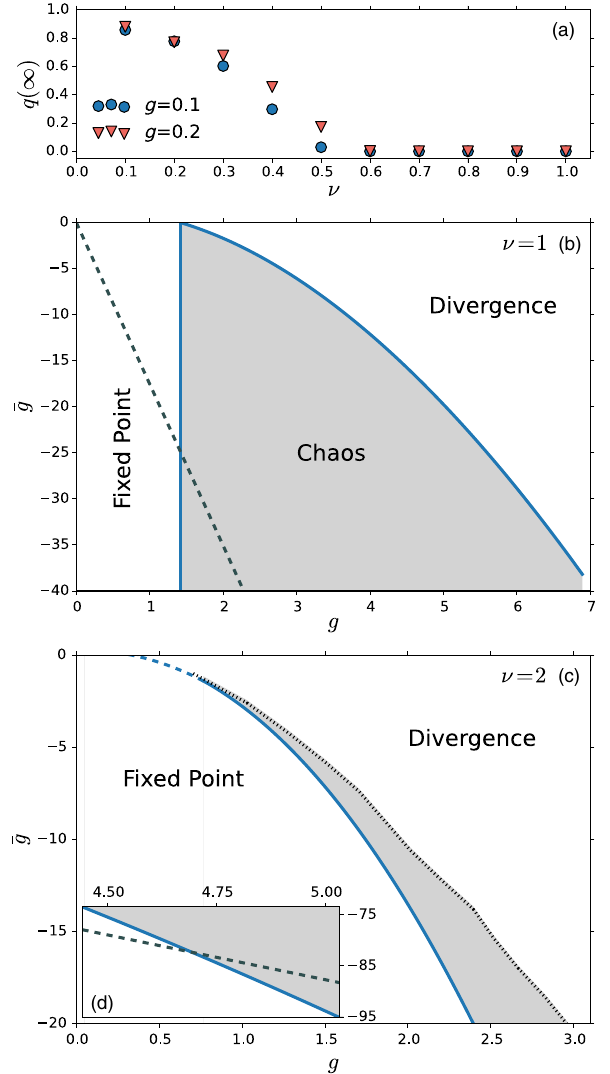
FIG. 2. Phasediagrams for a single inhibitory population. (a) No stable fixed point for sharp transfer functions. Simulation results for the normalized variance q ð ∞ Þ for networks with g ¼ 0 . 2 and g ¼ 0 . 1 and different values of the power law, ν , characterizing the rise of the transfer function, Eq. (33). Below ν ¼ 0 . 5 , the variance is nonzero, implying that there are temporal fluctuations even for low values of g . Simulation is performed on an inhibitory network ( N ¼ 5000 ) with randomly diluted connections and mean activity of m ¼ 0 . 1 . (b) Phase-space diagram for a threshold-linear ( ν ¼ 1 ) network of inhibitory neurons with mean connectivity ¯ g < 0 and variance g . The dashed line shows an example of a transition in a diluted network (with K ¼ 650 ) where, because ¯ g ¼ − Eq. (49)], the network lies on a line in the phase diagram. (c) Phase diagram for a threshold-quadratic ( ν ¼ 2 ) network with an excita- toryexternalfield h 0 ¼ 1 .Thedashedlineshowsuniforminstability of the fixed point, and the solid line shows the transition to the chaotic phase (shaded area). The dotted (black) line shows the instability of the chaotic phase found by simulations (Gaussian connectivity, N ¼ 6000 , h 0 ¼ 1 ). The inset (d) is the same as (c) for larger values of j ¯ g j . The dashed line shows the existence for a diluted network as in